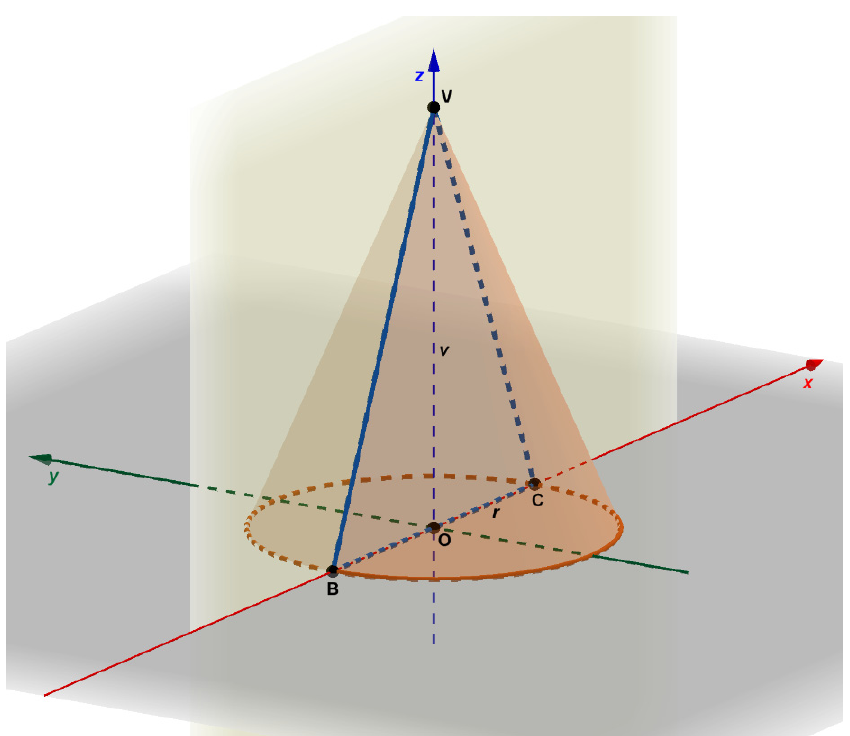
Figure 1. The initial cone of prop. I 11 of Apollonius. The cone has the base on the x–y plane, with center in the origin, the axis on the z -axis and vertex V in ( 0,0, v ) . We want to build a parabola on this